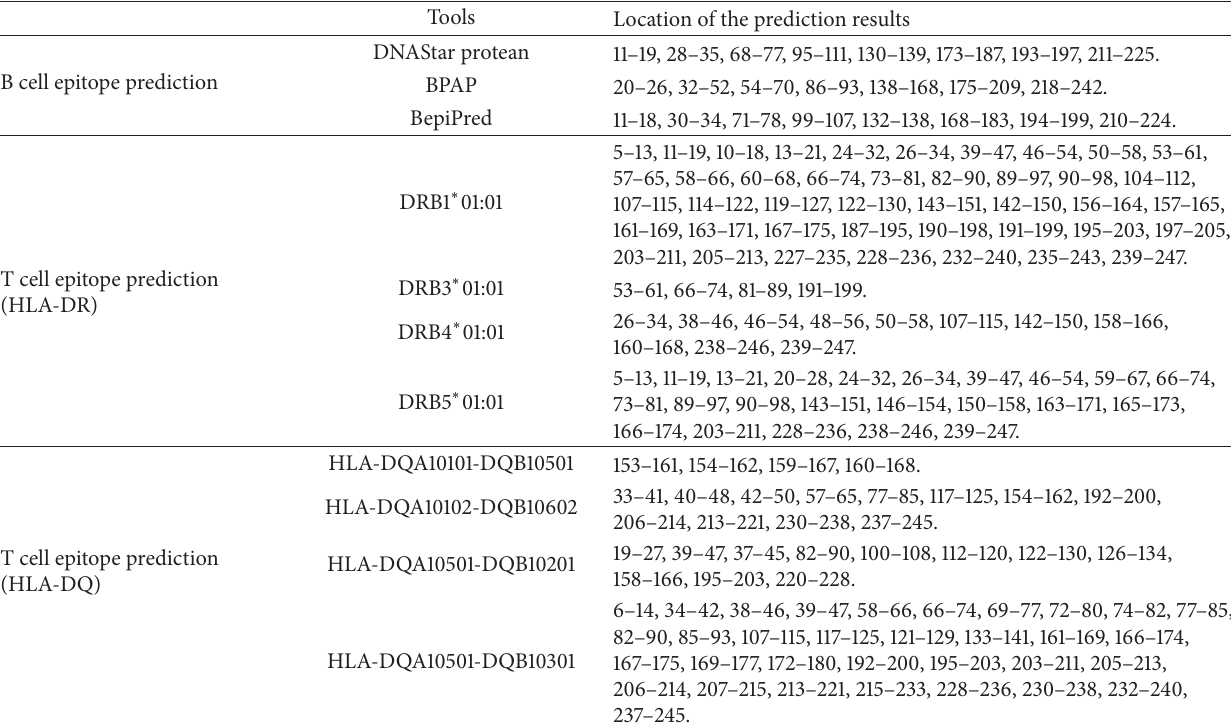
Table 3: The results of B and T cell epitopes